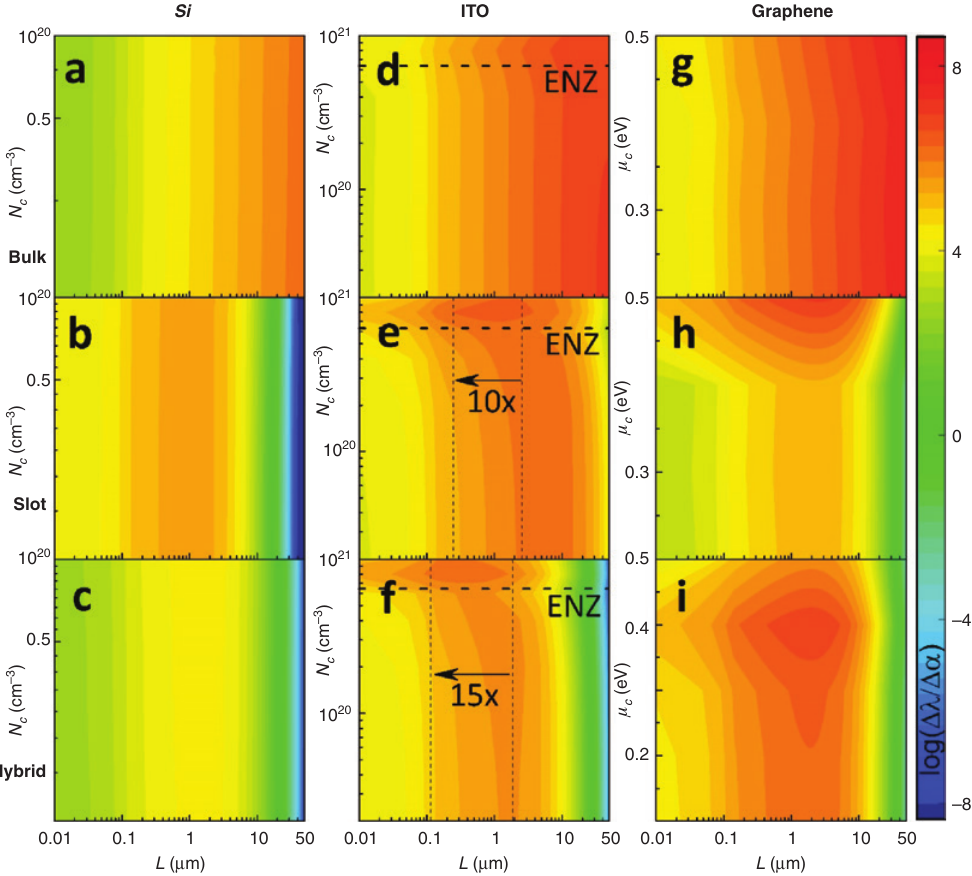
Figure 6: Fabry-Pérot-based cavity resonance shift-loss-ratio, i.e. log( Δ λ / Δ α ), vs. carrier concentration levels in cm –3 (for Si and ITO) and chemical potential in eV (for graphene) vs. scaling ( μ m) for all nine cavities based on the modes from Figure 2. Every point on the y axes on these graphs represent corresponding tuning from the start point in either carrier concentration (a–f) or chemical potential (g–i) to that point. Each color level in the color bar corresponds to a change of approximately 2.27 × 10 4 cm 2 in the actual Δ λ / Δ α